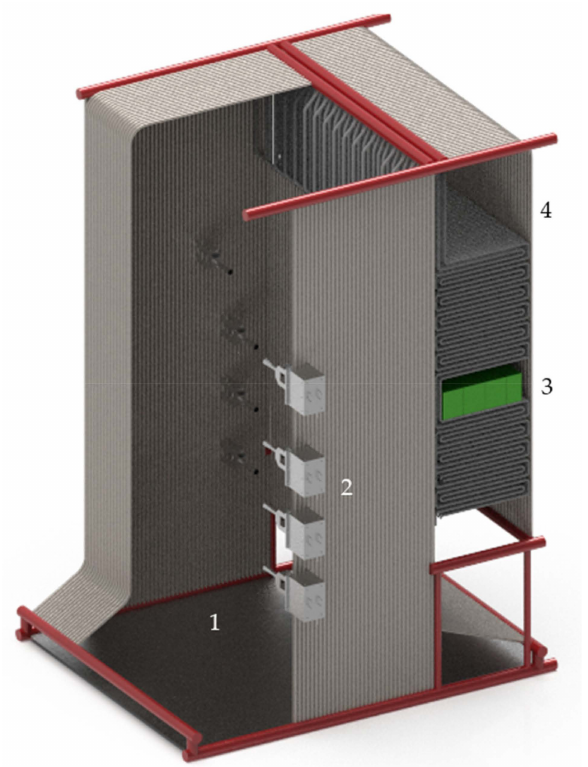
Figure 2. FJBS+ System: Arrangement of SNCR jet blowers in the combustion chamber and catalyst assembly in flue gas duct. 1-combustion chamber, 2-jet blowers, 3-catalyst, 4-flue gas